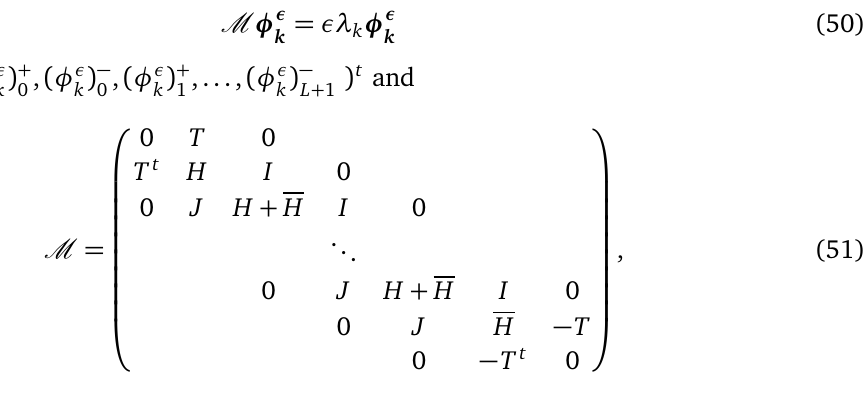
Figure 5: Spectral gap for the quench model for L = 60, p